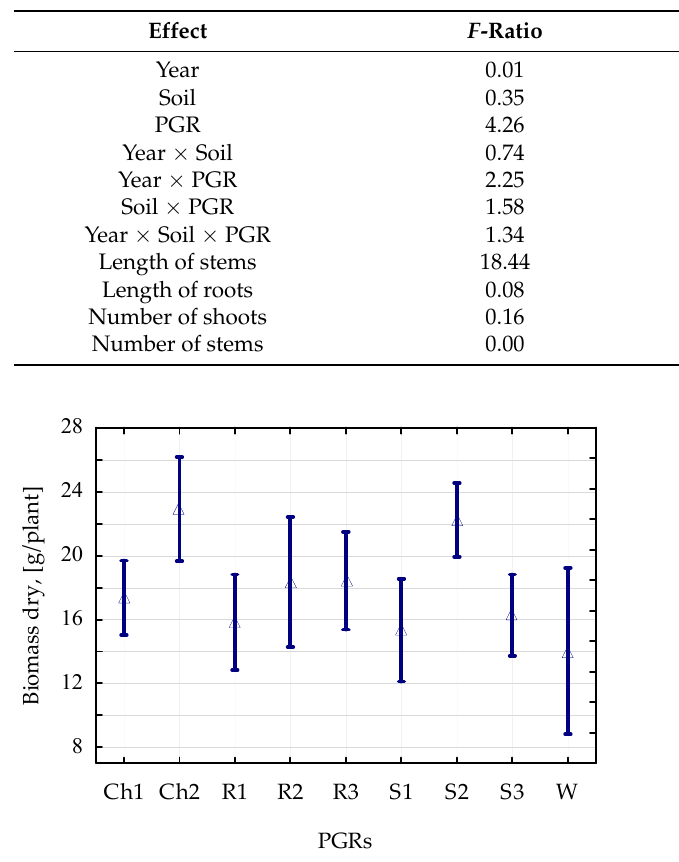
Figure 2. Impact of various PGR treatments on M. × giganteus dry biomass. Triangles show least square means. Vertical bars denote 0.95 confidence intervals.